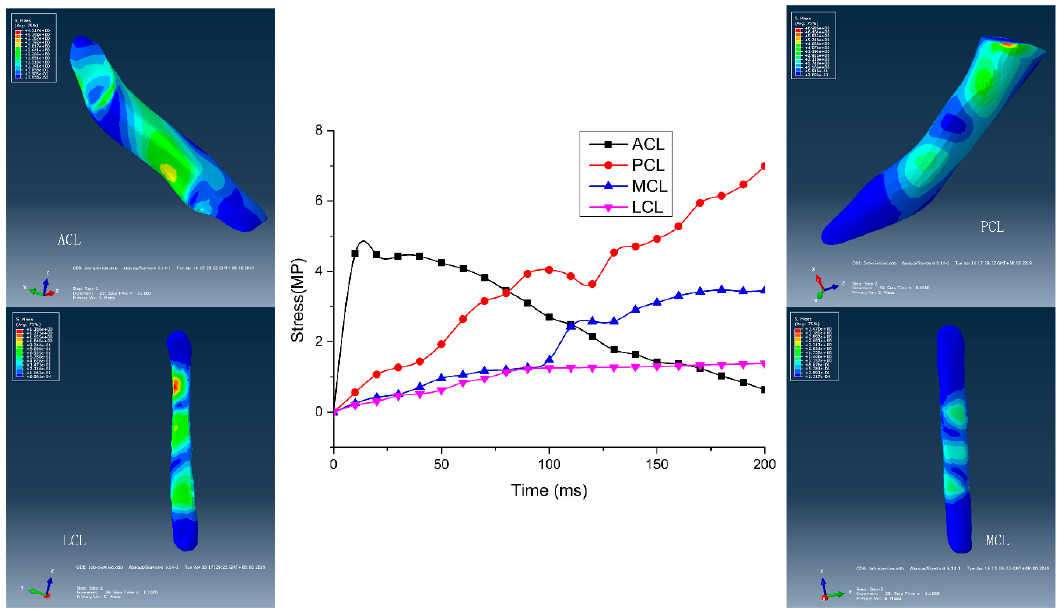
Figure 9. Distribution and stress–time curve of the ligaments in backward landing.